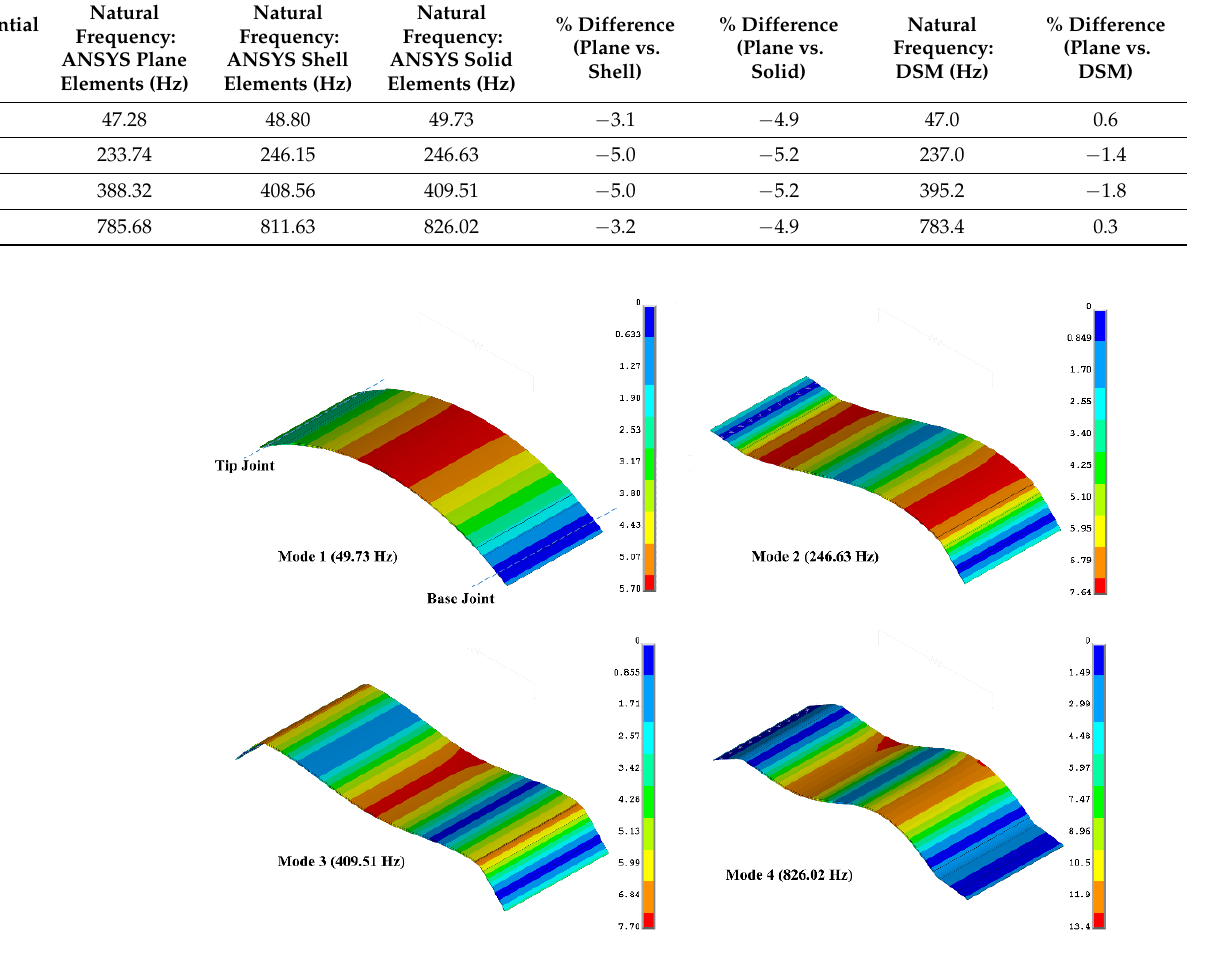
Figure 4. Mode shapes of THUNDER transducer section of device in Figure 1, using solid elements. The last two columns of Table 3 respectively show the DSM results for the undamped natural frequencies and the percentage differences relative to the ANSYS plane element results. It is clear that the ANSYS plane element results are much closer to the DSM results than to the ANSYS shell or solid element results. This is expected since the DSM model is directly based on beam-bending, and the ANSYS plane element model describes a similar beam-bending behavior, albeit modelled indirectly through plane elements (resulting in the small differences in the last column of Table 3). It should also be noted that, as seen from Section 2, DSM is a frequency domain method used to derive FRFs. Hence, unlike FE (ANSYS), the undamped natural frequencies in DSM are not found by solving an ei- genvalue problem since the final relation is a system of equations (Equation (30)) relating the nodal displacements and forces in the frequency domain (rather than an equation of motion in the time domain involving discrete mass and stiffness matrices). However, the undamped natural frequencies can be determined by DSM from the frequency locations of the peaks of the transmissibility FRF (Equation (31)) under zero damping conditions. For zero electrical load and no material damping, these resonance peaks would be infinite, and their frequencies are more accurately located by noting the zero crossing points of the (cid:4666)𝜔(cid:4667) ). It should also be noted that, denominator of Equation (31) (i.e., the FRF 𝛼 (cid:3051)(cid:3556) (cid:3118) , (cid:3007)(cid:3560) (cid:3299)(cid:3118)